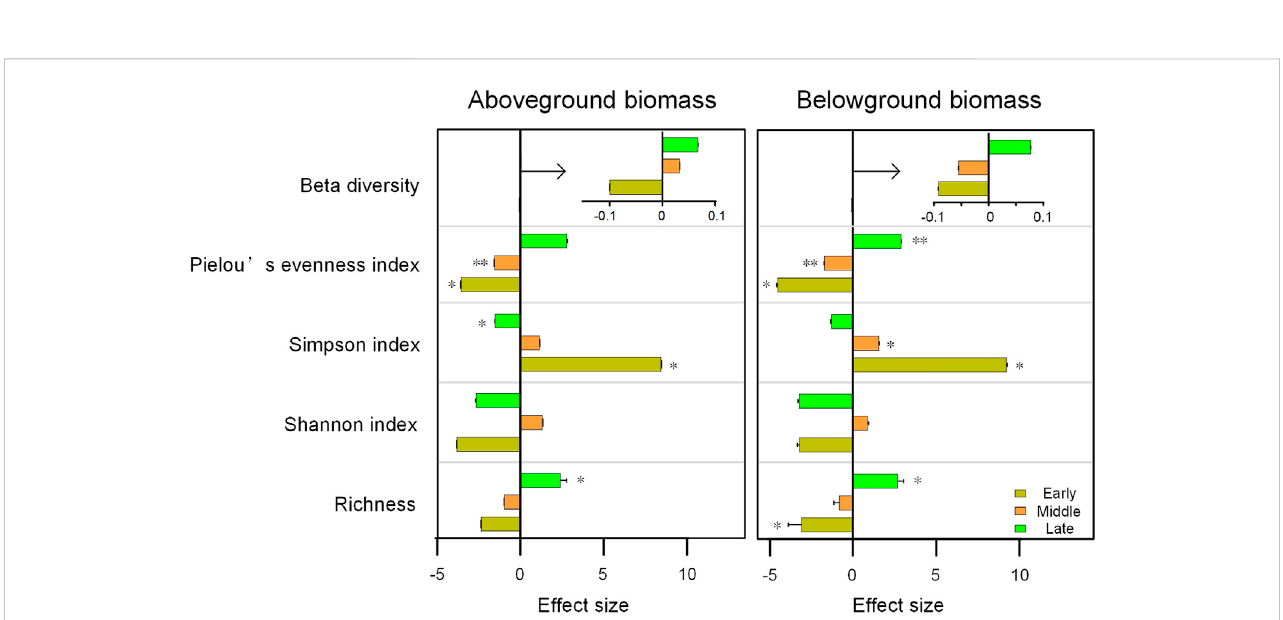
FIGURE 9 Comparison of the effects of plant diversity on aboveground and belowground biomass at different restoration stages. *, p < 0.05; **, p <